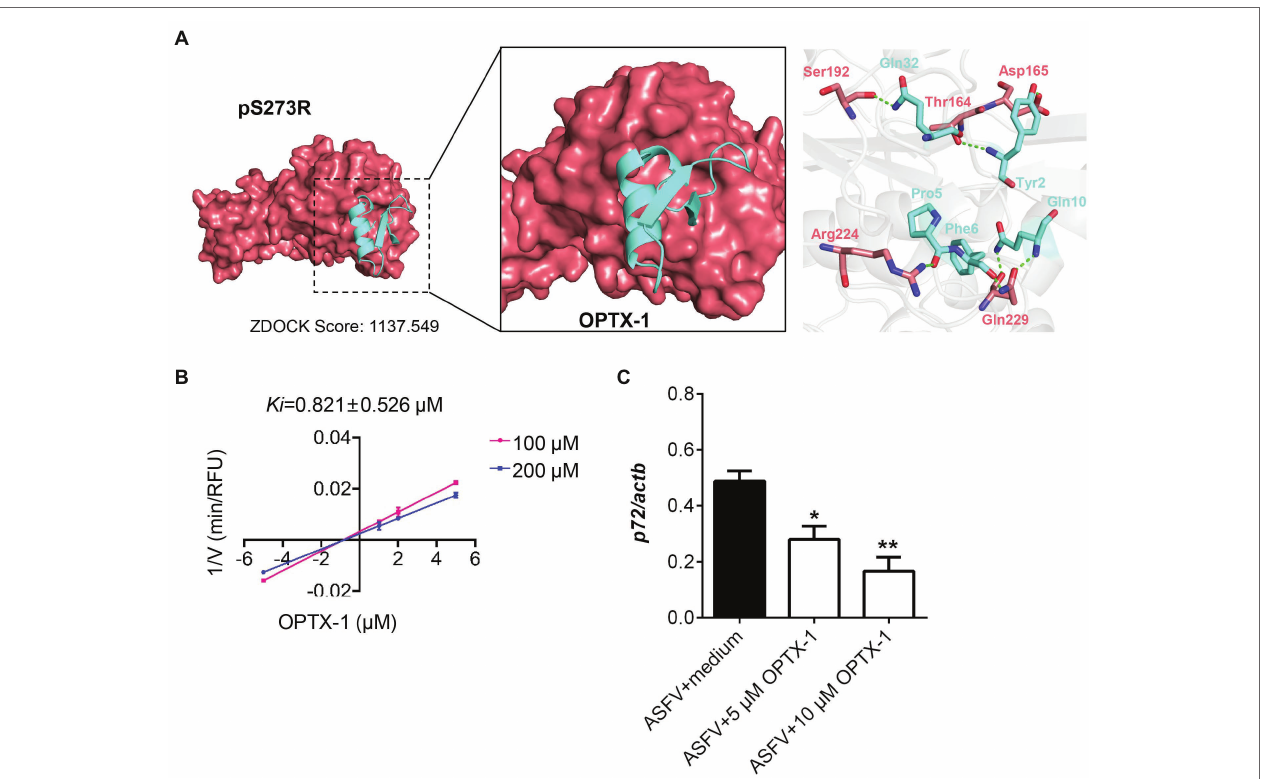
FIGURE 2 | OPTX-1 inhibits the activity of pS273R and the replication of ASFV. (A) Molecular docking between OPTX-1 and pS273R. The residues are shown as stick models. The hydrogen bonds are shown as dashed green lines. (B) The Lineweaver–Burk plot shows that OPTX-1 is a competitive inhibitor of the pS273R protease, and the Ki value was determined by the method of Dixon. V is the reaction rate. (C) OPTX-1 inhibits the replication of ASFV in PAM cells at 48 hpi. Data represent three independent experiments in A,B and two independent experiments in C . * p < 0.05 and ** p <